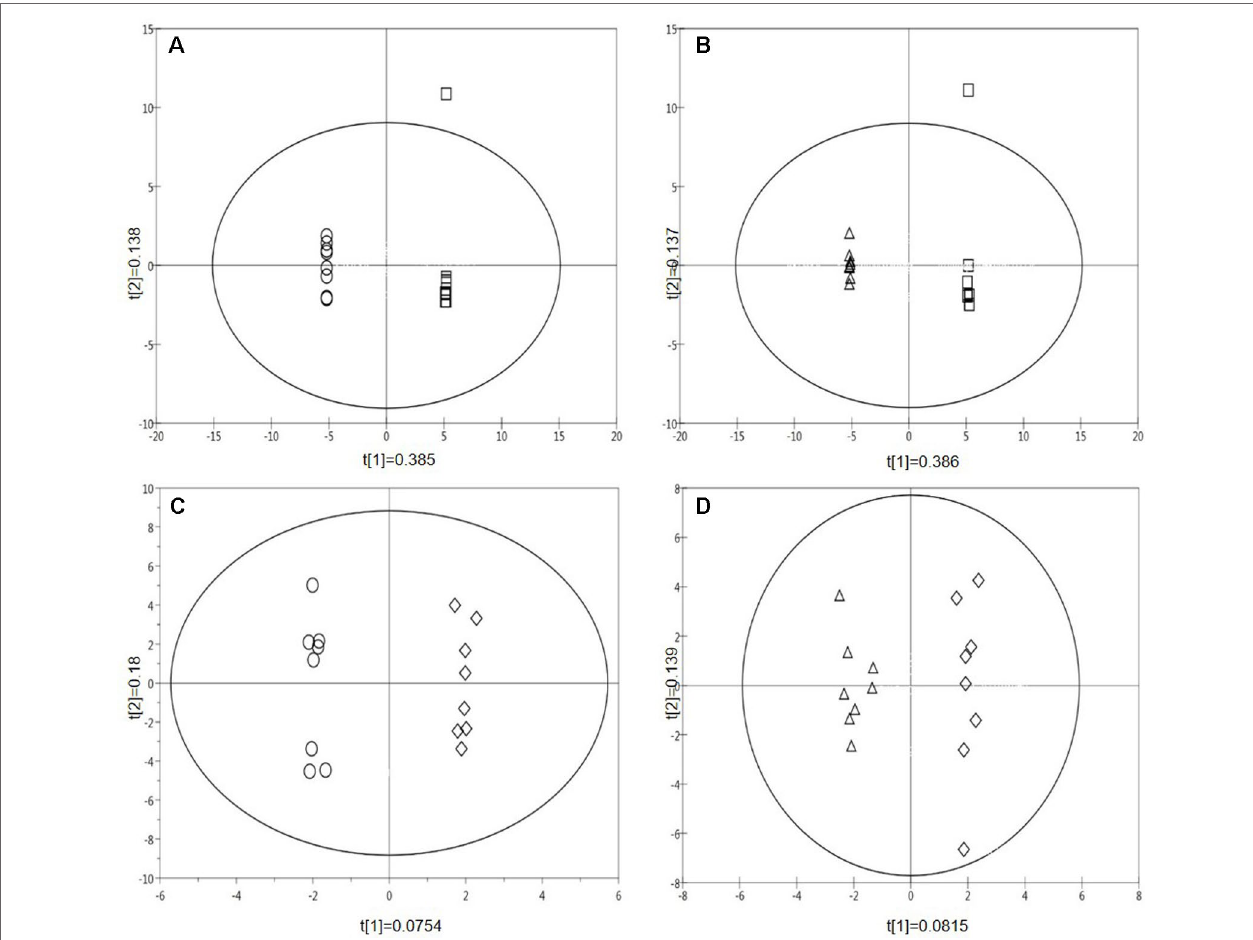
FIgURE 2 | Supervised multivariate OPLS-DA plots of pair-wise comparisons of the metabolite profiles of treatments for all leaf samples (Data points from MALDI- ToF analysis, polar phase, negative ionisation mode, 32 samples). (A) Hs vs. control; (B) eCO 2 vs. control; (C) Hs* eCO 2 vs eCO 2 ; (D) Hs*eCO 2 vs Hs. (Circle=Hs, square=control, triangle=eCO 2 , diamond=Hs*eCO 2